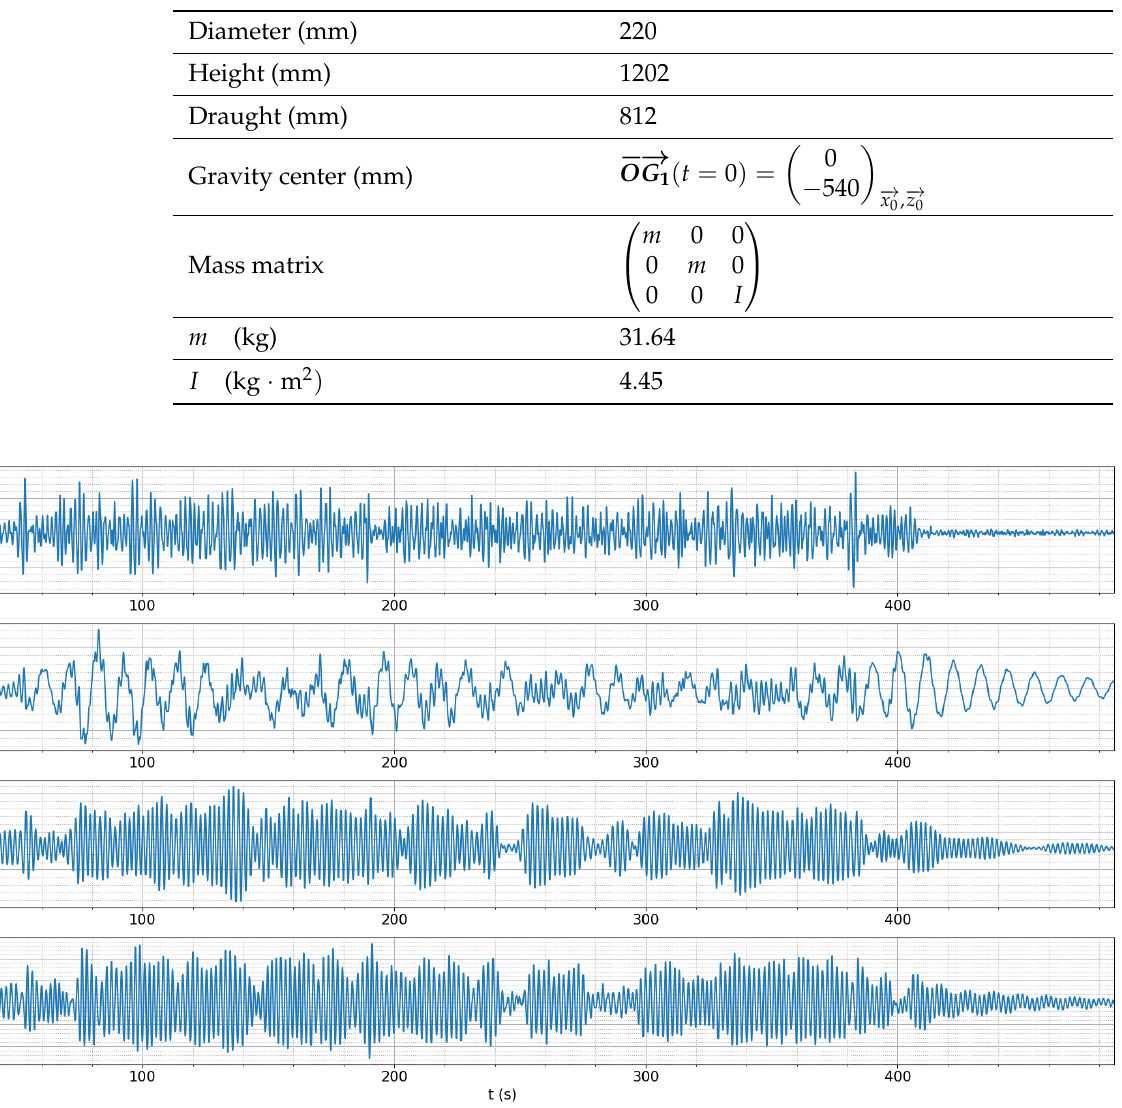
Figure 9. Experimental time series of the waves elevation and the cylinder